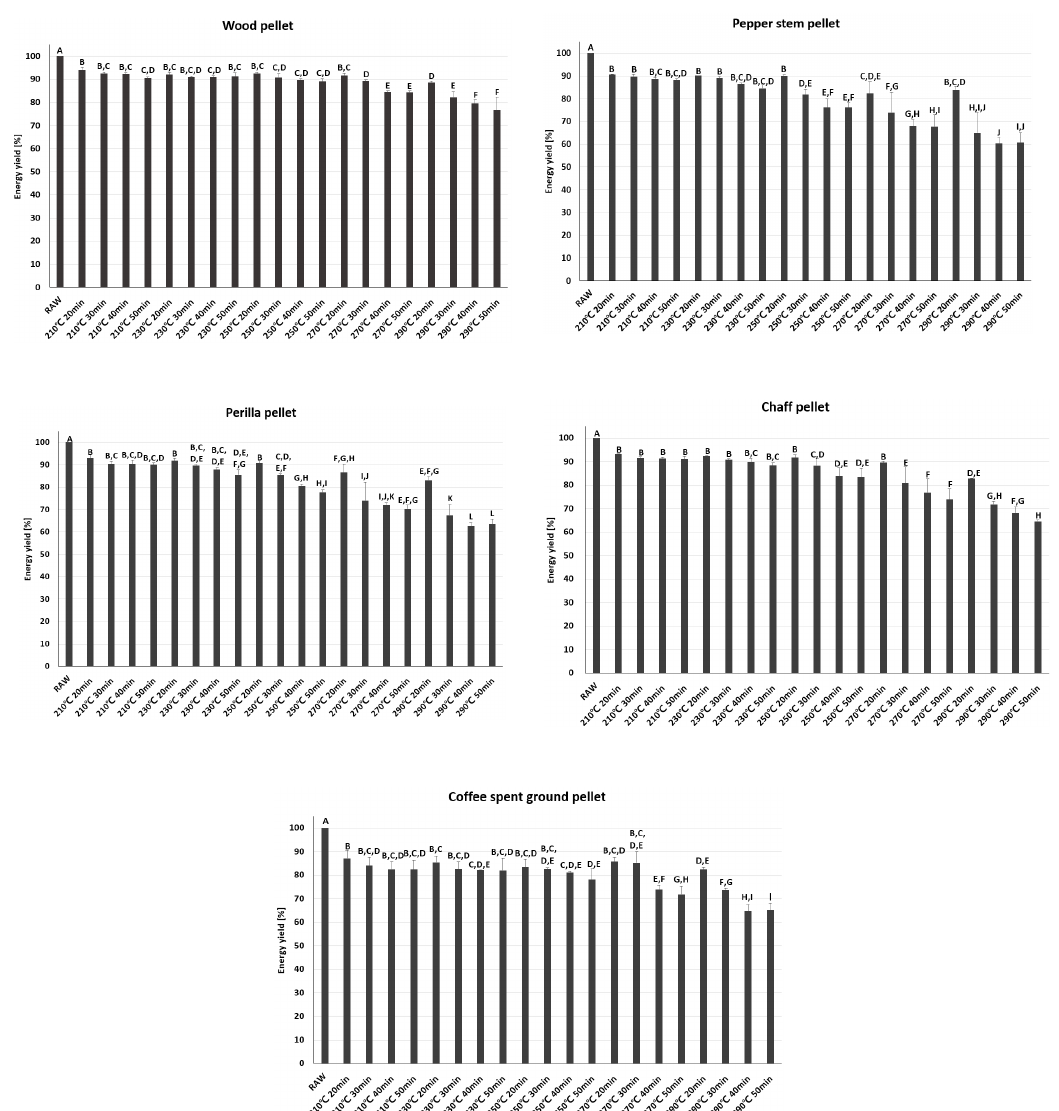
Figure 4. Calorific value of each pellet for various temperature and time conditions. Each letter in the graph is a group of significance determined by Duncan’s multiple test.